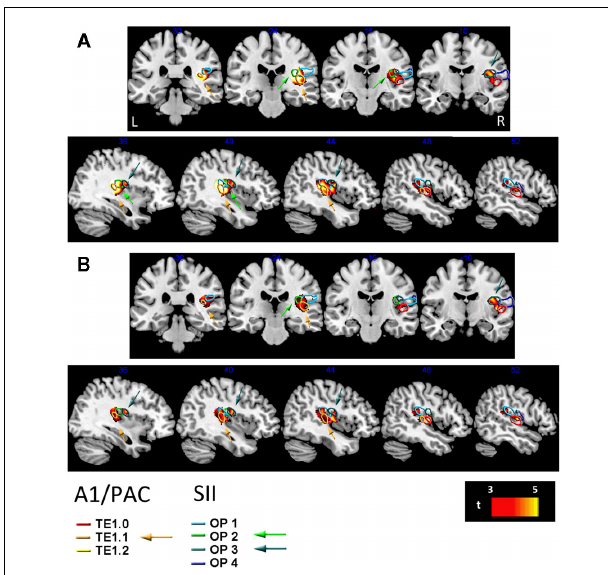
FIGURE 4 | Overlay of longer duration structural correlates on right A1/PAC (primary auditory) and SII (secondary somatosensory) cortices. Cortical loci where our analyses of cortical thickness revealed a significant positive correlation between cortical thickness and longer auditory [Aud12, (A) ] or longer visual [Vis12, (B) ] duration discrimination shown in red to bright yellow ( t -values indicated on scale bar) superimposed on structures of A1/PAC and SII. A1/PAC and SII structures are denoted by colored contours according to the legend at the bottom (see Materials and Methods). Coronal (top) and sagittal (bottom) views. Arrows point to substantial portions of these structures that are correlated with longer duration discrimination ability, which areTE1.1 (PAC/A1, see orange arrows) and OP2–3 (SII, see blue and turquoise arrows). See also Figures 5A–C . R, right; L,